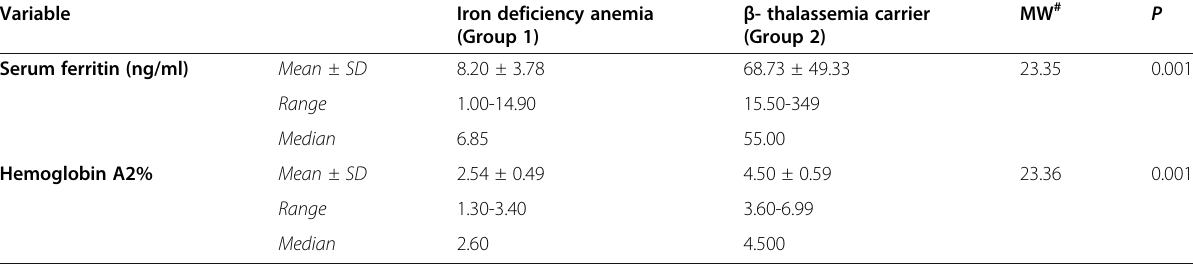
Table 3 Serum ferritin and HbA2 of β thalassemia carriers and iron deficiency anemia participants Mid Nile Delta Egyptian